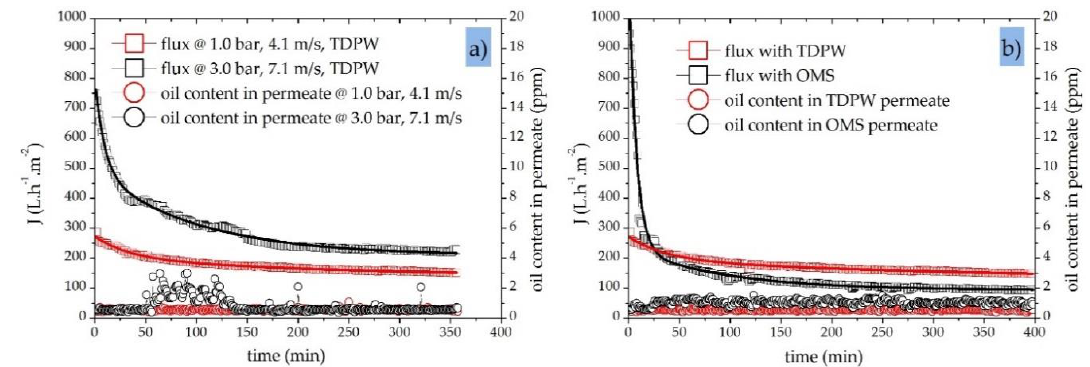
Figure 8. Permeate flux and oil content in permeate samples for a 40 nm SiC UF membrane. ( a ) Permeate flux and oil content during the filtration of TDPW at di ff erent TMPs (1.0 and 3.0 bar) and di ff erent CFVs (4.1 and 7.1 m · s − 1 ); T = 50 ◦ C in fed-batch mode; initial oil concentration in feed = 200 ppm. ( b ) Permeate flux and oil content during the filtration of TDPW (initial oil concentration = 200 ppm) and OMS (initial oil concentration = 30 ppm); TMP = 1.0 bar; CFV = 4.1 m · s − 1 ; T = 50 ◦ C in fed-batch